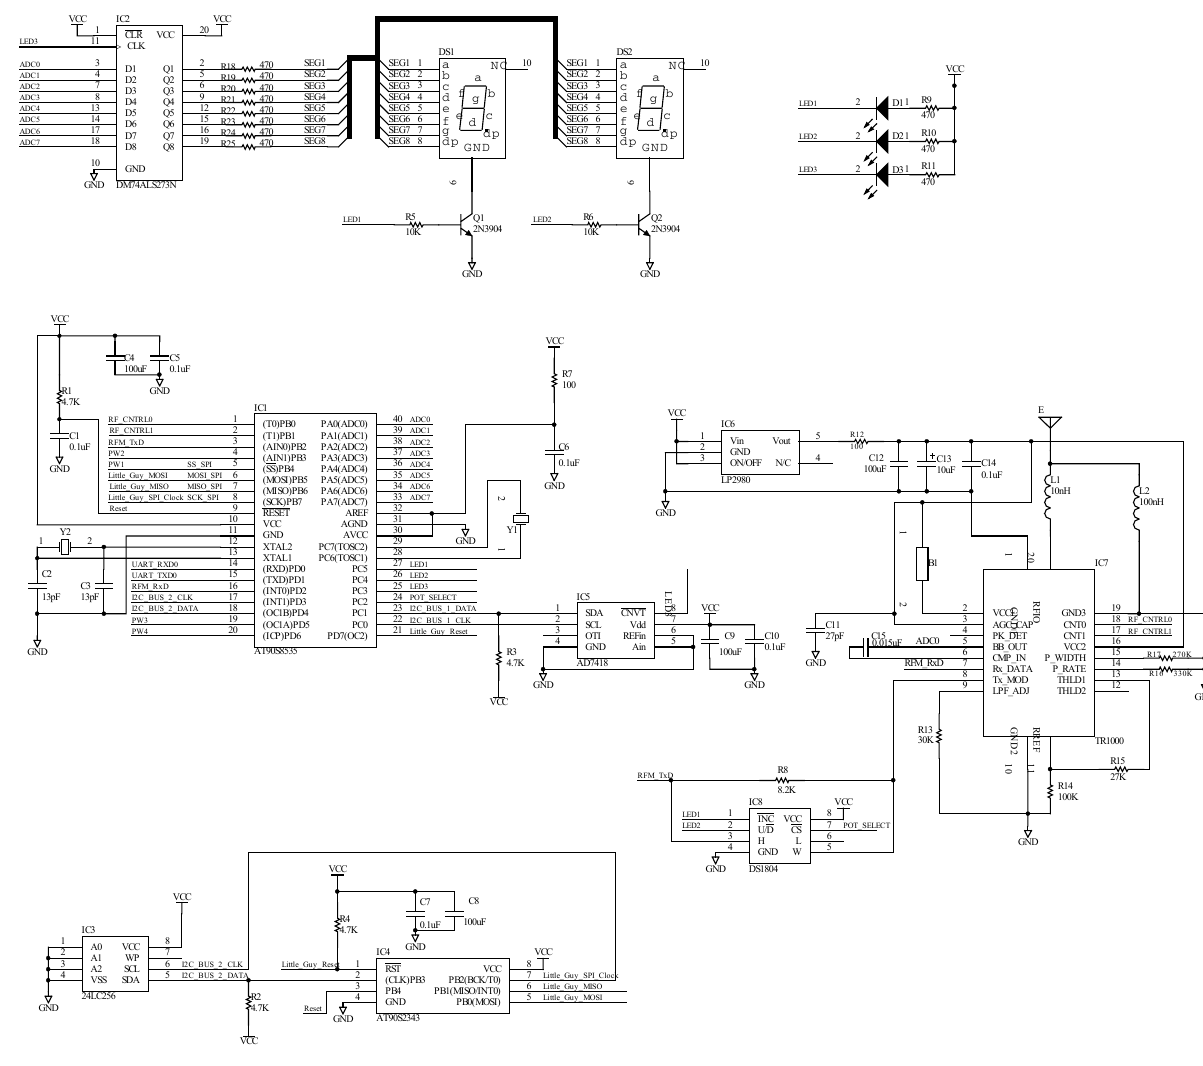
Figure 5. Circuit schematic of the main node controller module. The top portion of the schematic is the displaying section, the center portion is the microcontroller used to control node operations, and the bottom portion is a co-processor used for re-programming of the